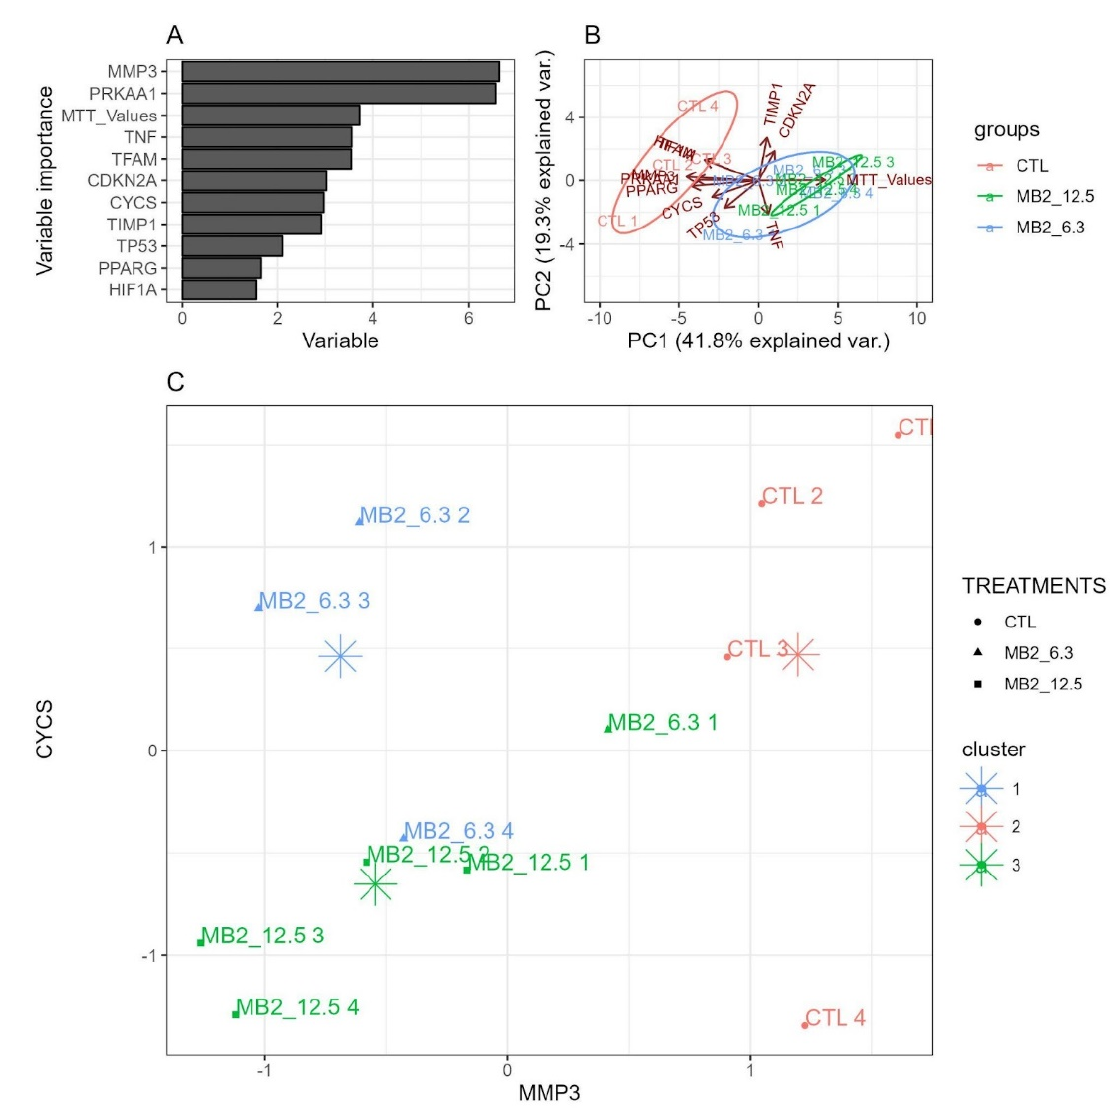
Figure 8. Information gain of different transcripts and MTT values that resulted from a random forest algorithm for condition prediction. Panel ( A ) shows the top 11 non-redundant variables that best split the data. Panel ( B ) shows a PCA data reduction on the top 11 variables. Panel ( C ) shows a k-means cluster analysis of the 6 least correlated variables that best split the data (PCA) into 3